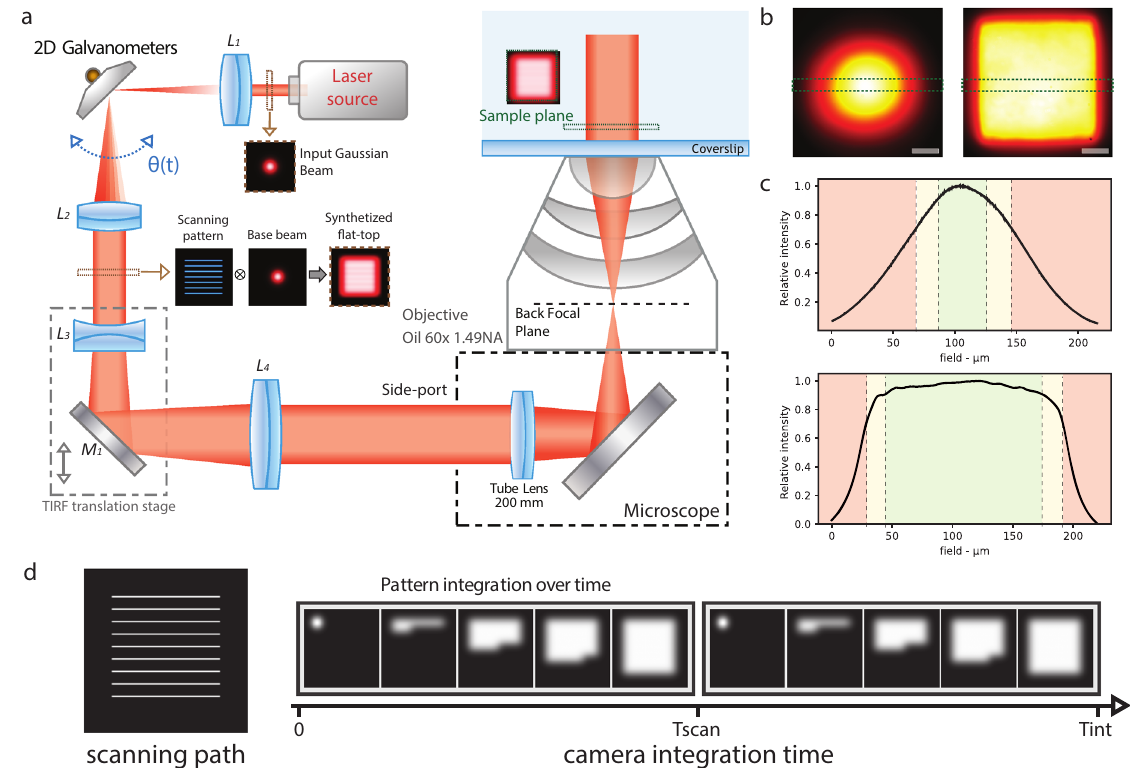
Fig. 1 Schematic of ASTER and resulting illumination patterns. a Simpli fi ed schematic of ASTER setup generating a homogeneous fi eld using a raster scanning pattern. L i are lenses with focal length fi : f1 = 100, f2 = 100, f3 = − 35, f4 = 250. M 1 is a dielectric mirror. A small input Gaussian base beam is scanned in-between the L 1 and L 2 lenses, resulting in a collimated fl at-top pro fi le, which then goes through a TIRF translation stage and is magni fi ed between L 3 and L 4 . After focalization at the BFP of an objective lens, it results in a temporally averaged fl at-top excitation pro fi le at the sample. b Thin layer of fl uorescent Nile Blue imaged at low laser power with a fi xed Gaussian excitation beam (left) and with ASTER (right) raster scanning excitation. Scalebars 40 µ m. c intensity pro fi les from b of Gaussian (up) and ASTER (bottom) illuminations taken along the green dashed area. Dashed lines and colors indicate the fi eld ranges in which intensity is above 90% (green), between 70 and 90% (yellow) or below 70% (red) of its maximum value. d Scanning path (left) and generation of the uniform pro fi le over temporal acquisition of the camera. (right). With Tint the camera integration time, the example of a scanning period Tscan = Tint/2 is